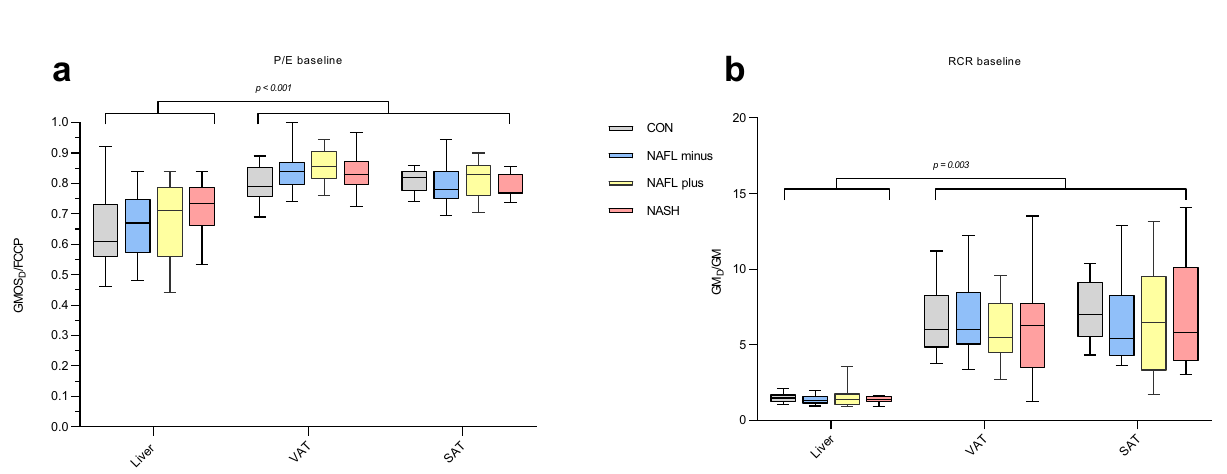
Fig. 4 P/E and RCR in tissue. a P/E (OXPHOS max /FCCP) in liver tissue, visceral adipose tissue (VAT) and subcutaneous adipose tissue (SAT); b Respiratory control ratio (RCR), (GM D /GM) in liver tissue, VAT and SAT. P/E and RCR were signi fi cantly higher (P/E: P < 0.001, RCR P = 0.003) in VAT and SAT when compared with liver tissue. No signi fi cant differences in P/E and RCR were found among the four groups in the three tissues. Data are median (horizontal line), interquartile range (boxes) and 10 – 90% percentile (error bars). P -values (2-sided) are Kruskal – Wallis pairwise comparison with correction for multiple comparison. Grey boxes; CON ( n < 10), blue boxes; NAFL − , yellow boxes; NAFL + , red boxes; NASH. Source data are provided as a Source Data fi le. Speci fi c n ’ s for each tissue and group are provided in the Source Data fi